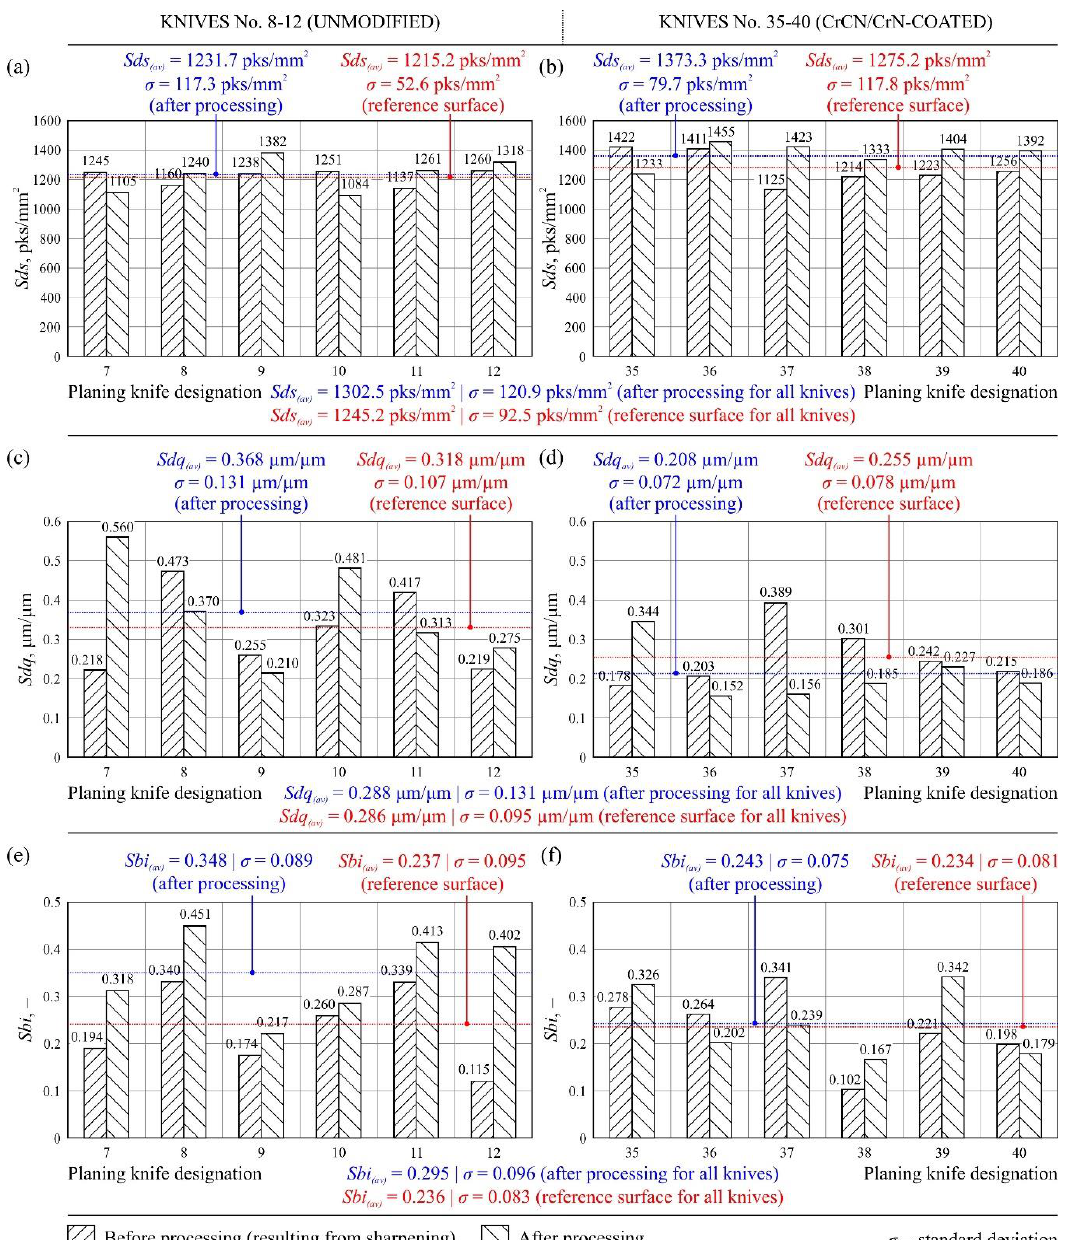
Figure 12. Values of texture parameters of the rake faces of ( a , c , e ) unmodified knives No. 7–12 and ( b , d , f ) CrCN / CrN-coated knives No. 35–40: ( a , b ) density of summits of the surface ( Sds ); ( c , d ) root-mean-square slope of the surface ( Sdq ); ( e , f ) surface bearing index ( Sbi ) .